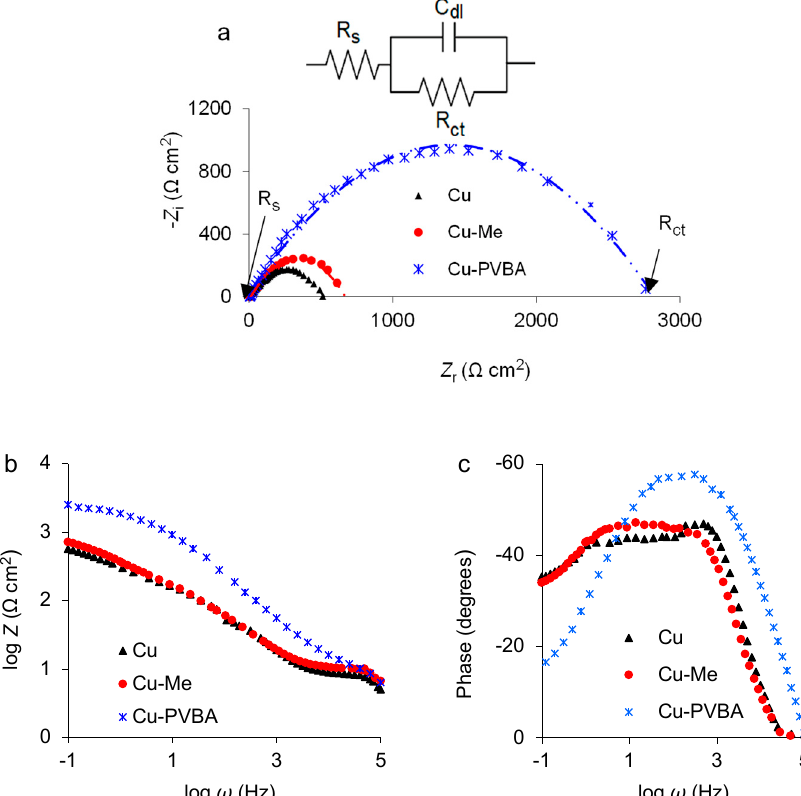
Figure 2. Nyquist ( a ), impedance Bode ( b ), and phase Bode ( c ) diagrams for standard copper, methanol-treated copper (Cu-Me), and PVBA modified copper (Cu-PVBA) recorded in 0.9% NaCl solution.